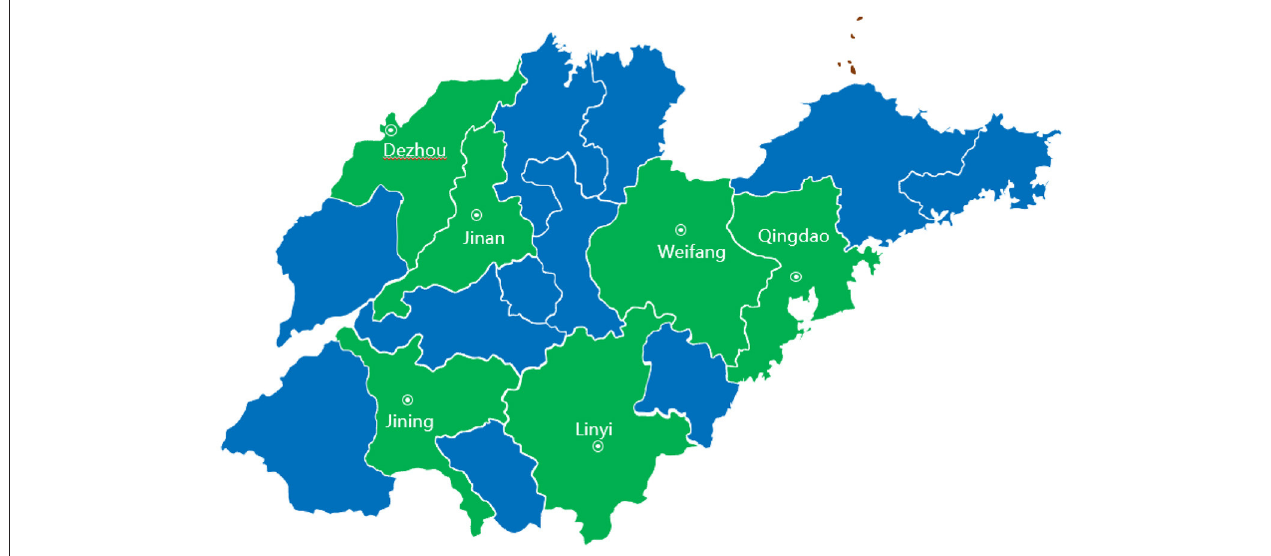
FIGURE 1 | Sampling cities of this study in Shandong